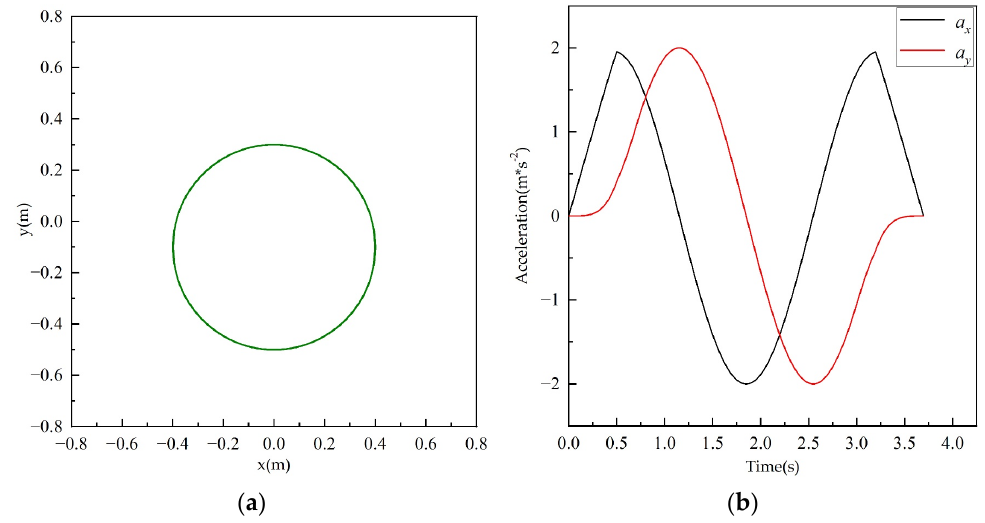
Figure 6. Parabolic motion trajectory and acceleration of moving platform. ( a ) Motion trajectory; ( b ) Acceleration curve.